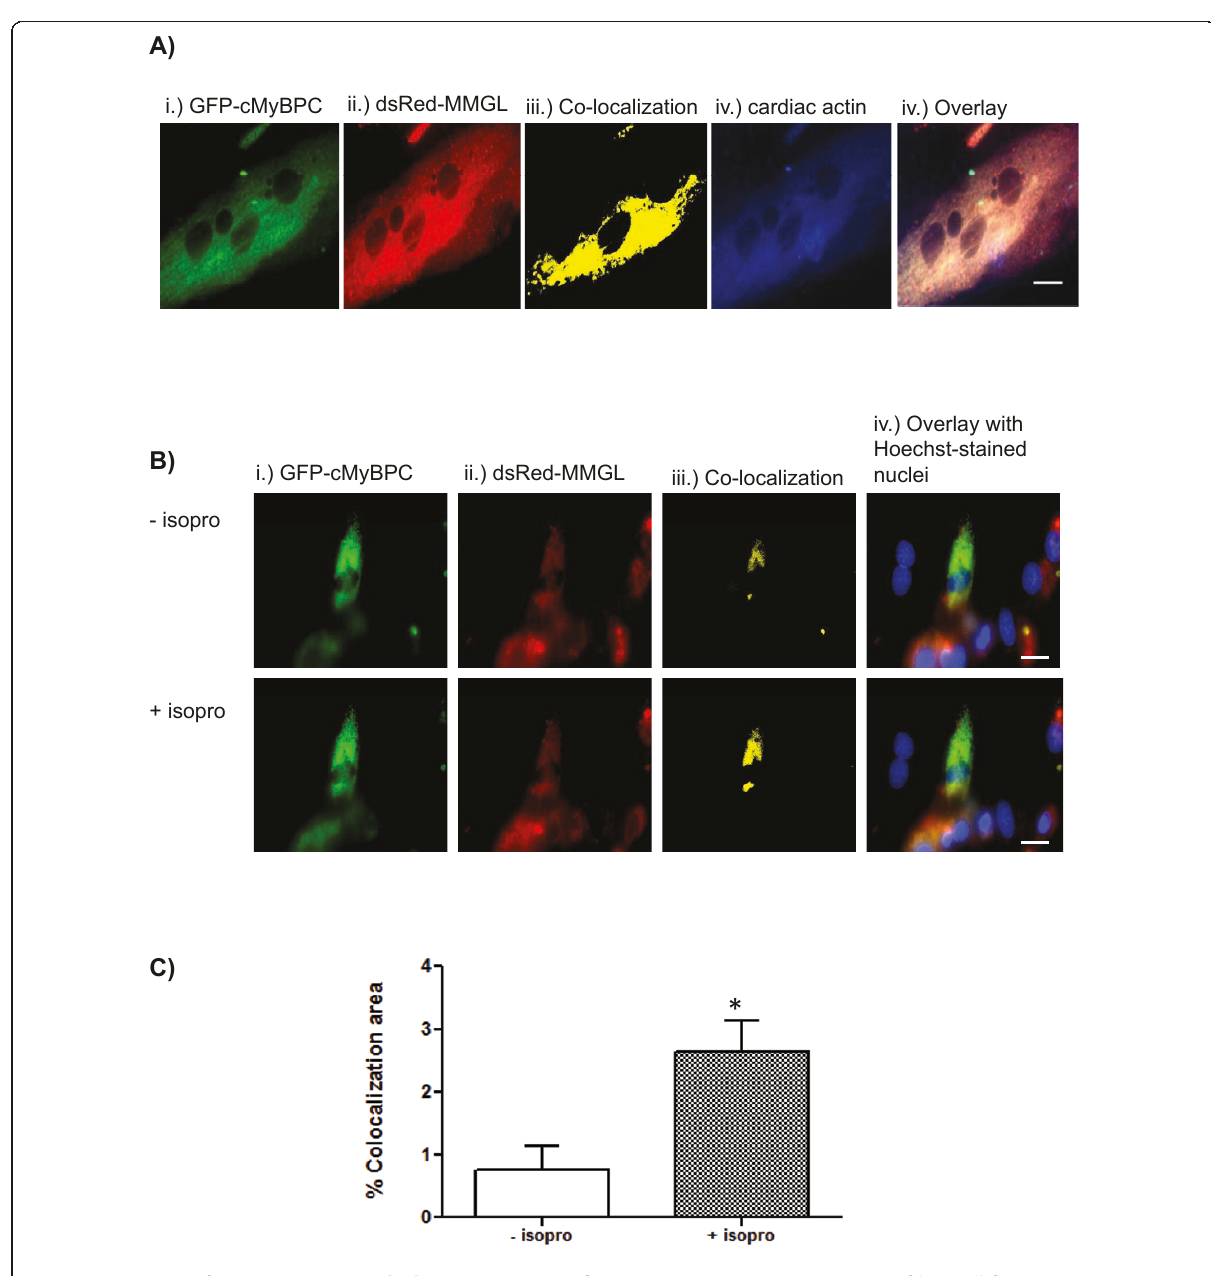
Figure 1 MMGL isoform 4 interacts with the C1-C2 region of cMyBPC . A . Representative image of live cell fluorescence microscopy showing co-localization of cMyBPC and MMGL isoform 4. Each panel represents a single frame of the 25 images that were captured for the vertical Z-stack. The first four panels shows a single colour channel, while the image in the last panel shows an overlay of the four colour channels used. Column (iii) shows co-localization (yellow fluorescence) between dsRed-MMGL and GFP-cMyBPC, while column (iv) shows cardiac actin, a marker of the sarcomeric region. Scale bar: 0.02 mm. B . Representative image of live cell fluorescence microscopy showing that co- localization of MMGL isoform 4 and cMyBPC increases under adrenergic stress. Each panel represents a single frame of the 25 images that were captured for the vertical Z-stack. Each of the first three columns shows a single colour channel, while the image in the last column shows an overlay of the four colour channels used. Column (iii) shows co-localization (yellow fluorescence) between dsRed-MMGL and GFP-cMyBPC in the absence (-isopro) and presence (+isopro) of the beta-adrenergic agonist, isoproterenol. As evidenced by the increased yellow staining, co- localization levels between MMGL and cMyBPC increased ten minutes after the addition of isoproterenol. Scale bar: 0.02 mm. C . Quantification of co-localization shown in B demonstrates the significant increase in co-localization after the addition of isoproterenol (± SEM, * p < 0.05, n = 5). Change in co-localization was calculated using the CellR software and presented as a false colour image and percent co-localization as described by Loos et al ., 2008 [29]. Abbreviations: isopro =